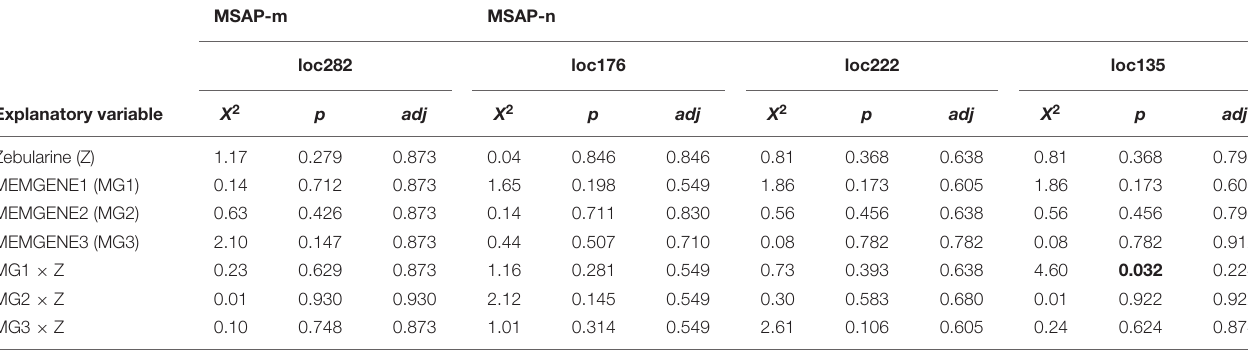
TABLE 4 | Summary of likelihood-ratio tests from logistic mixed-effects models applied to outlier loci detected jointly via the genome-scan approaches LFMM and